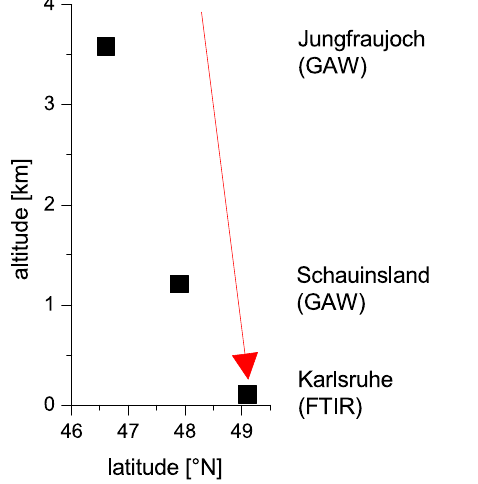
Figure A1. Location of the Central European GAW stations and the Karlsruhe FTIR instrument. Red arrow is indicative for the line of sight of the FTIR instrument.